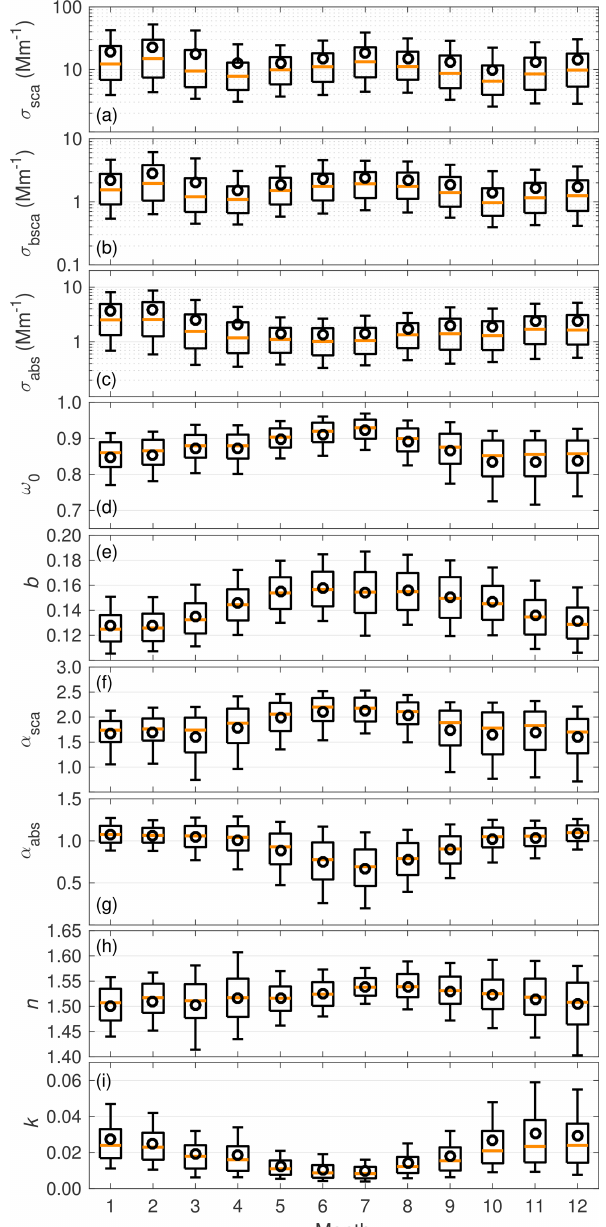
Figure 1. Seasonal variation in the aerosol optical properties for PM 10 particles. The boxes represent the 25th and 75th percentiles and the whiskers the 10th and 90th percentiles of the data. The or- ange line is the median and the mean is presented with a black cir-